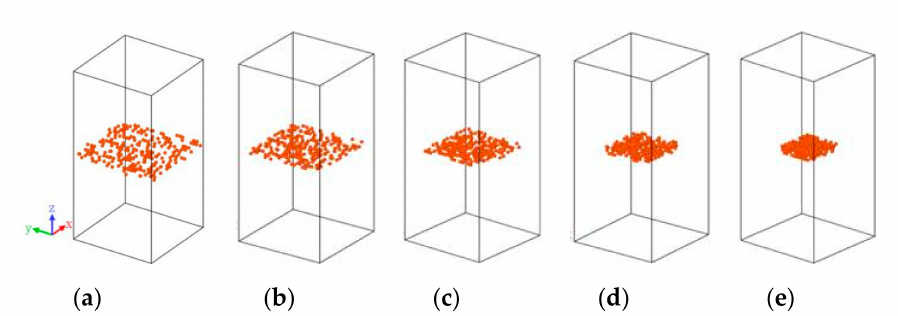
Figure 2. Schematic diagram of the regions of Cu atoms in the model ( a ) the original region, ( b – e ) regions after the X and Y axis sizes are successively